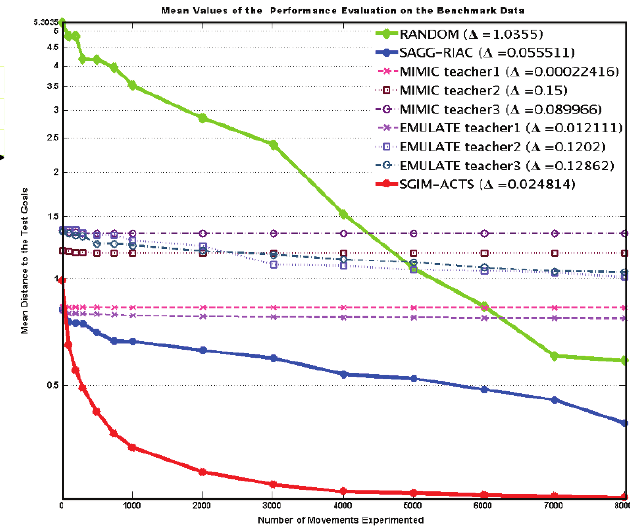
Figure 6. Mean error for the di(cid:636)erent learning algorithms averaged over the two suboutcomespaces(finalvariancevalue